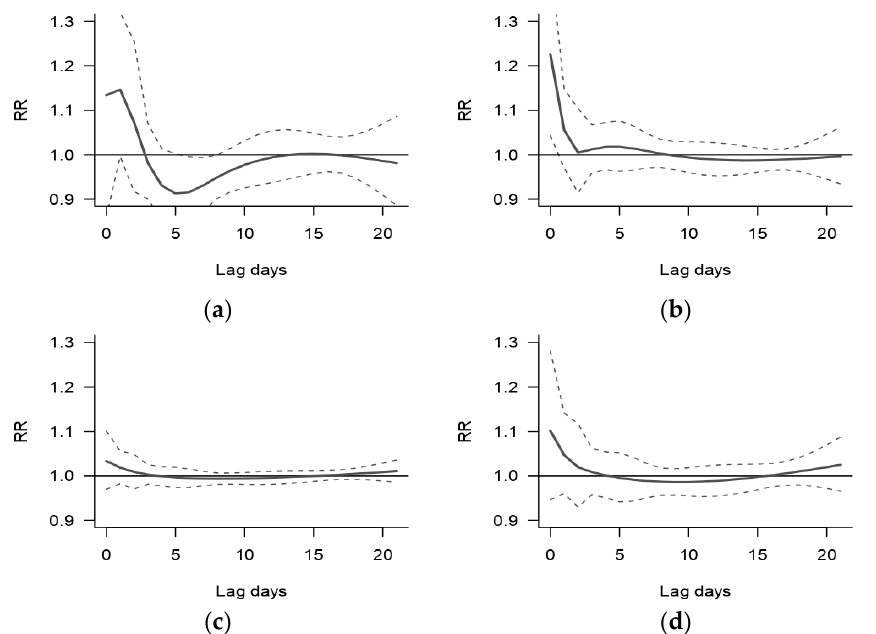
Figure 5. The relative risk (RR) of CVD hospital admissions by lag days at; ( a ) 9 °C; ( b ) 16 °C, ( c ) 28 °C; and ( d ) 30 °C in Limpopo, South Africa. The dotted lines show the 95% CI. The RRs are compared to an optimal T app of 26 °C.